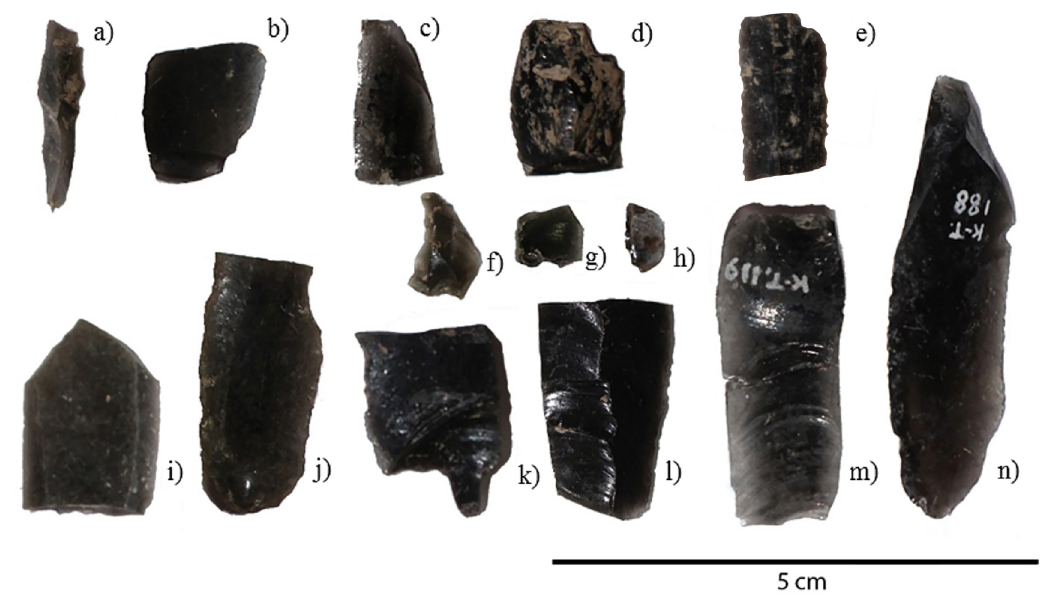
Figure 4. The fourteen artefacts whose elemental composition is beyond the expected ranges for Göllüdağ, the main supplier of obsidian to Cyprus, suggesting additional obsidian sources are represented in the assemblages. [Note: a=5038-95-46 ( Shillourokambos ), b=5038-97-1 ( Shillourokambos ), c=5038-98-2 ( Shillourokambos ), d=5038-95-6 ( Shillourokambos ), e=5038-99-225 ( Shillourokambos ), f=KMYL1982 ( Mylouthkia ), g=5038-92-17 ( Shilourokambos ), h=KMYL1227 ( Mylouthkia ), i=5038-97-297 ( Shillourokambos ), j=5038-92-10 ( Shillourokambos ), k=5038-97-299 ( Shillourokambos ), l=5038-97-28 ( Shill- ourokambos ), m=KT119 ( Tenta ), n=KT188 ( Tenta )].